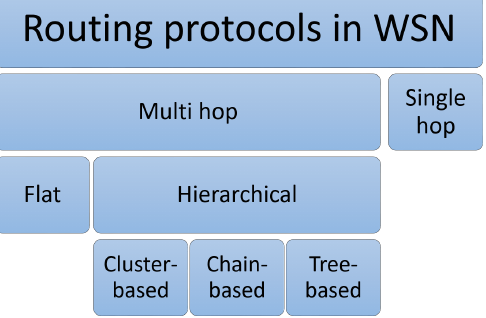
Figure 1. Routing protocols in WSN.